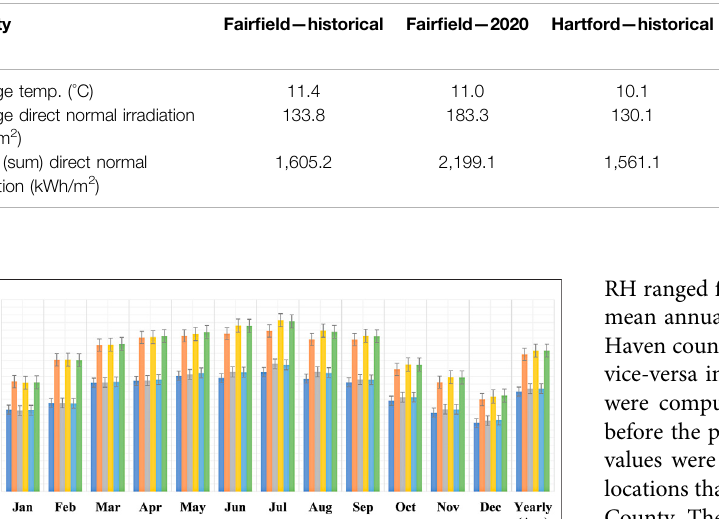
TABLE 5 | Summary of the mean annual temperatures and direct normal irradiation in the locations.